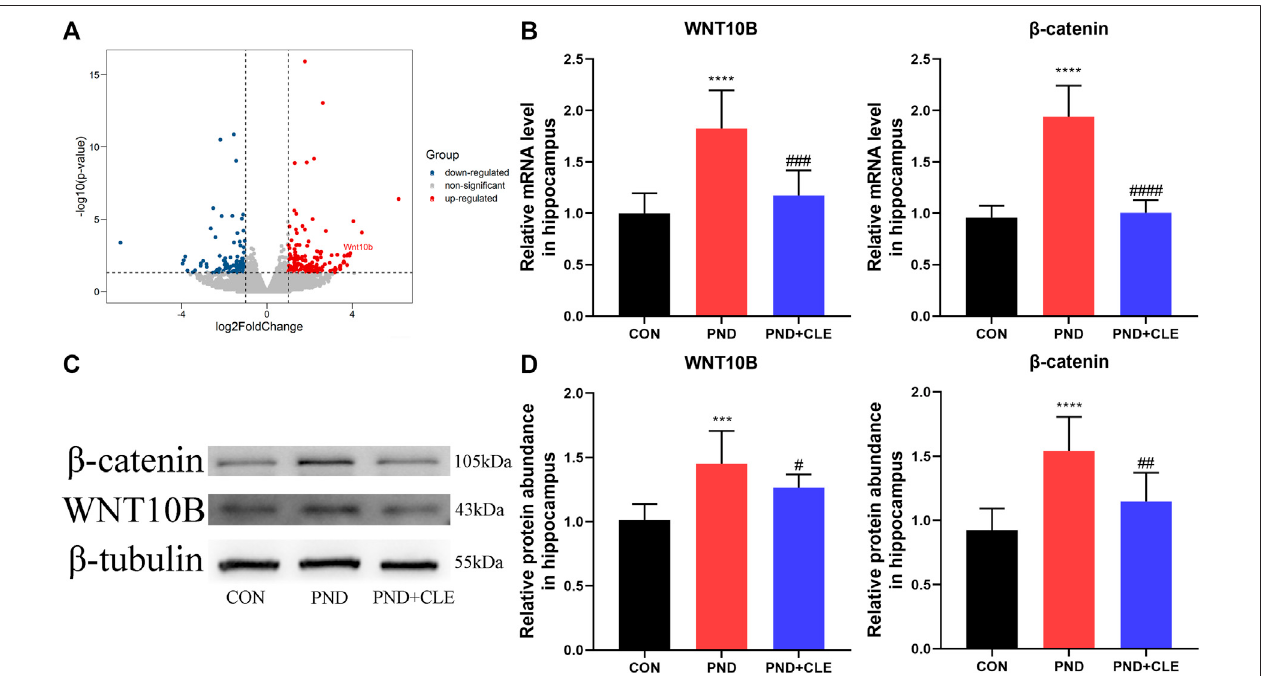
FIGURE 4 | Effects of clemastine on expression levels of WNT/ β -catenin signaling pathway. ( A ) The differential expression of WNT10B was labeled in our previous sequencingresults.( B )RelativemRNAexpressionsofWNT10Band β -catenin,normalizedtothatoftheGAPDHinternalcontrol.( C )Representativewesternblotimages of WNT10B and β -catenin. ( D ) Relative protein expressions of WNT10B and β -catenin, normalized to that of the β -tubulin internal control. The data are presented as mean ± S.D.( n (cid:1) 10micepergroup).*** p < 0.005compared withtheCONgroup.**** p < 0.001compared withtheCONgroup. # p < 0.05compared withthePND group. ## p < 0.01 compared with the PND group. ### p < 0.005 compared with the PND group. #### p < 0.001 compared with the PND